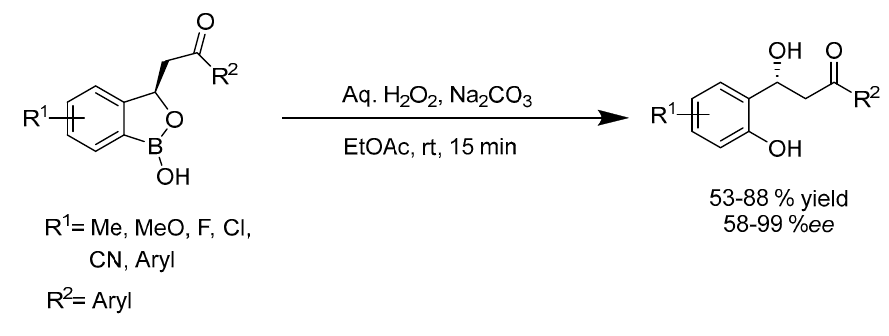
Scheme 13. Synthesis of β -hydroxy ketones.